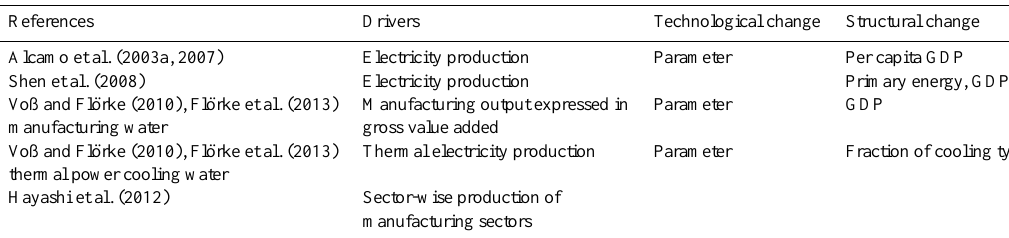
Table 3. Summary of industrial water withdrawal estimation models in earlier studies.